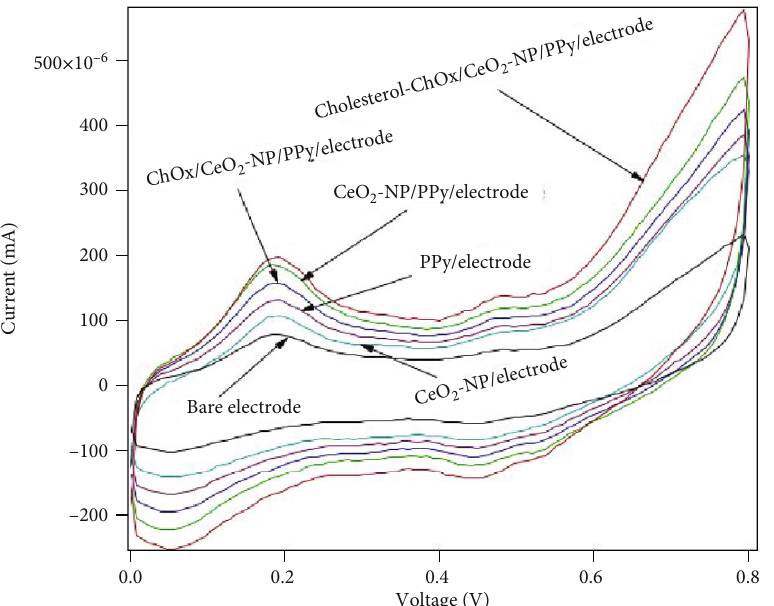
Figure 4: CV of bare electrode, CeO cholesterol-ChOx/CeO